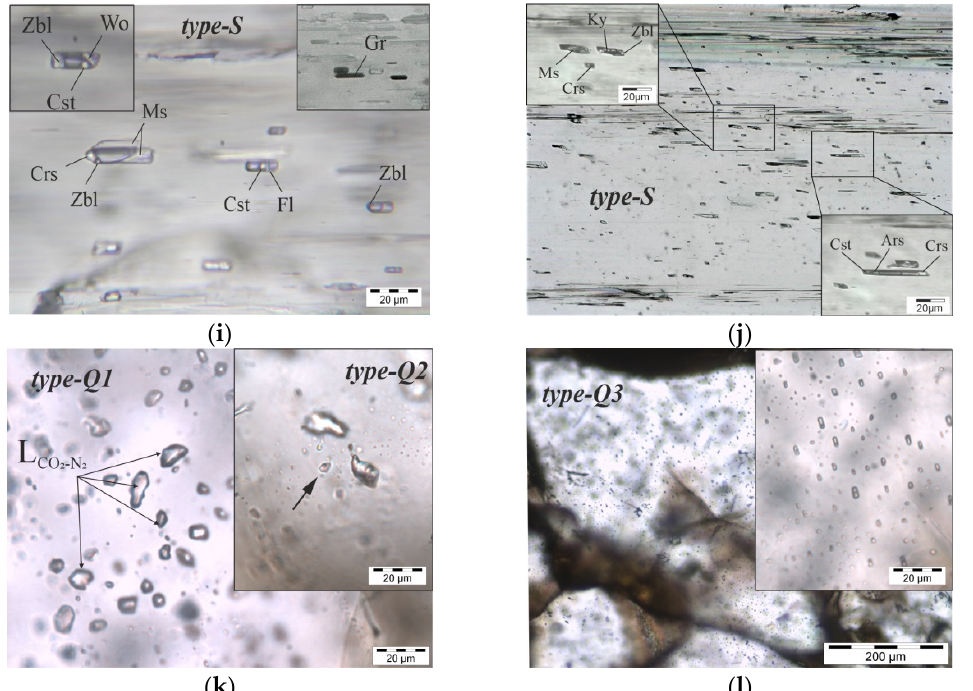
Figure 3. Fluid inclusion types. ( a ) Primary type-N FIs consisting of liquid N 2 (L N2 ) and solids (Rt = rutile, Ms = muscovite, and Rds = rhodochrosite). Detail: necking-down of type-N inclusion results into two separate FIs that are connected by a thin tube. ( b ) Primary type-A aqueous inclusions containing Rds (left image); apatite (Ap) and Ms (right image) (L H2O = liquid H 2 O, V H2O = vapor H 2 O). ( c ) Type-G FIs consisting of liquid CO 2 -N 2 (L CO2-N2 ) and various solids (Ms, Rds, Cal = calcite, Ky = kyanite). Detail shows Type-G FI and solids Ms, Rds and Gr (graphite). ( d ) Plane of type-N and type-A FIs nearby a muscovite solid inclusion. FIs have an irregular shape and show variations in volume proportions because of the presence or absence of solids (type-N). Type-A FIs show necking and consist of one-phase liquid. ( a , b , d ) from samples WB01/02 and ( c ) from sample Kor_3. ( e ) Type-T1 FIs in tourmaline from sample W05. FIs are primary, one-phase liquid and show negative crystal shape. ( f ) Type-T2 FIs in tourmaline from sample W04. FIs are two-phase and entrapped near graphite-bearing cracks. ( g ) Type-T2 FIs in tourmaline from sample W04. FIs are necked and entrapped near graphite inclusions. Insert shows trail orientation (dashed line) of secondary graphite-bearing type-T2 FIs towards the edge of the tourmaline crystal. ( h ) Tourmaline poikiloblast from sample WB01. CO 2 -N 2 -bearing FIs (one phase liquid) with well-preserved rounded shapes entrapped in enclosed quartz aggregates. ( i ) Type-S FIs from spodumene host of sample W08. FIs are polyphase and entrapped parallel to cleavage planes of the host. FIs in detailed images have a size of ca. 20 μ m. ( j ) Polyphase Type-S FIs in spodumene host from sample Klem_1. ( k ) Type-Q1/Q2 FIs from a quartz section of sample WB02. Cluster type-Q1 FIs are one-phase liquid (L CO2-N2 ). Insert: necked large CO 2 -N 2 FIs nearby a small two-phase aqueous FI (black arrow; type-Q2). ( l ) Cluster of small type-Q3 FIs in recrystallized quartz, crossing grain boundaries. Insert shows that FIs are oriented, have constant liquid/vapor proportion, and a common shape.